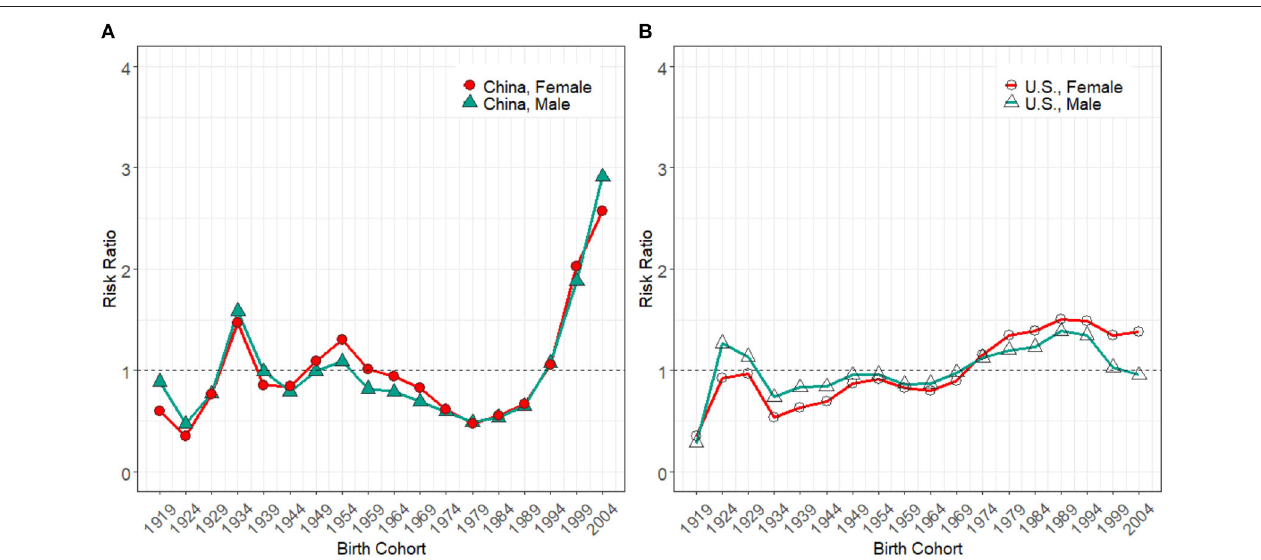
FIGURE 5 | Cohort effect on HIV/AIDS incidence rate for male and female in China (A) and the U.S. (B) from 1994 to